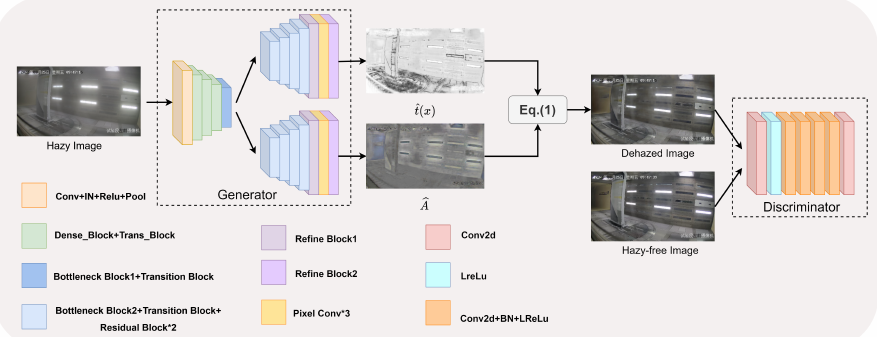
Figure 1. An overview of the proposed Dense-HR-GAN image dehazing method. It includes a generator and a discriminator. The generator is responsible for generating physical parameters (cid:98) t ( x ) and (cid:98) A . Then, the atmospheric scattering model is inverted to output a dehazed image. Finally, the discriminator discriminates between the dehazed image and the haze-free